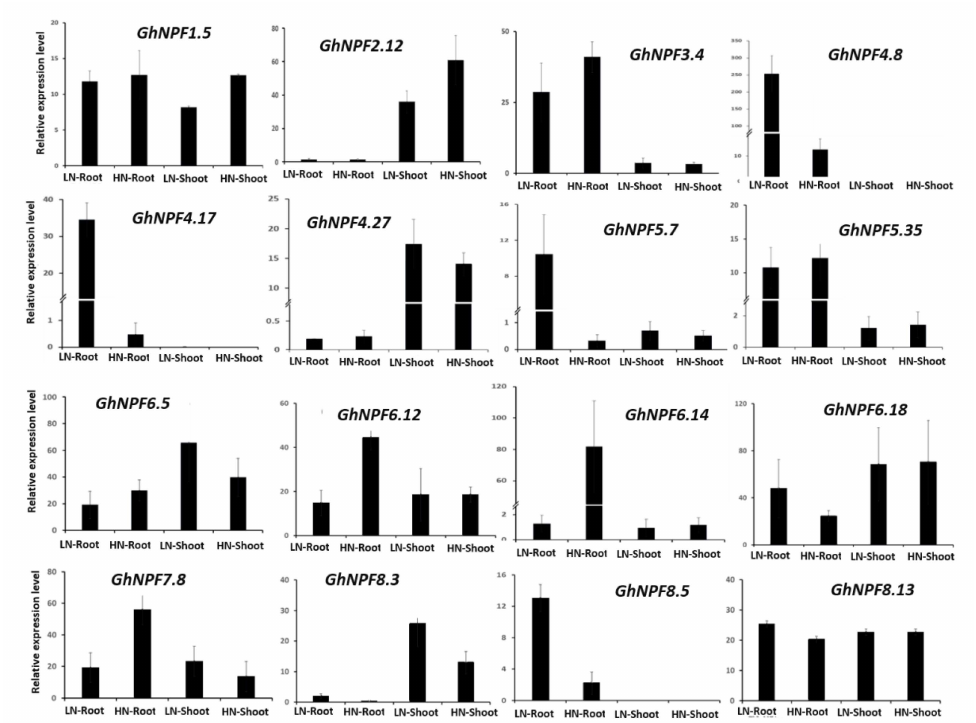
Figure 6. Relative expression patterns of 16 GhNPF genes under N deficiency treatments were analyzed by qRT-PCR. Error bars indicate the standard deviations of three independent